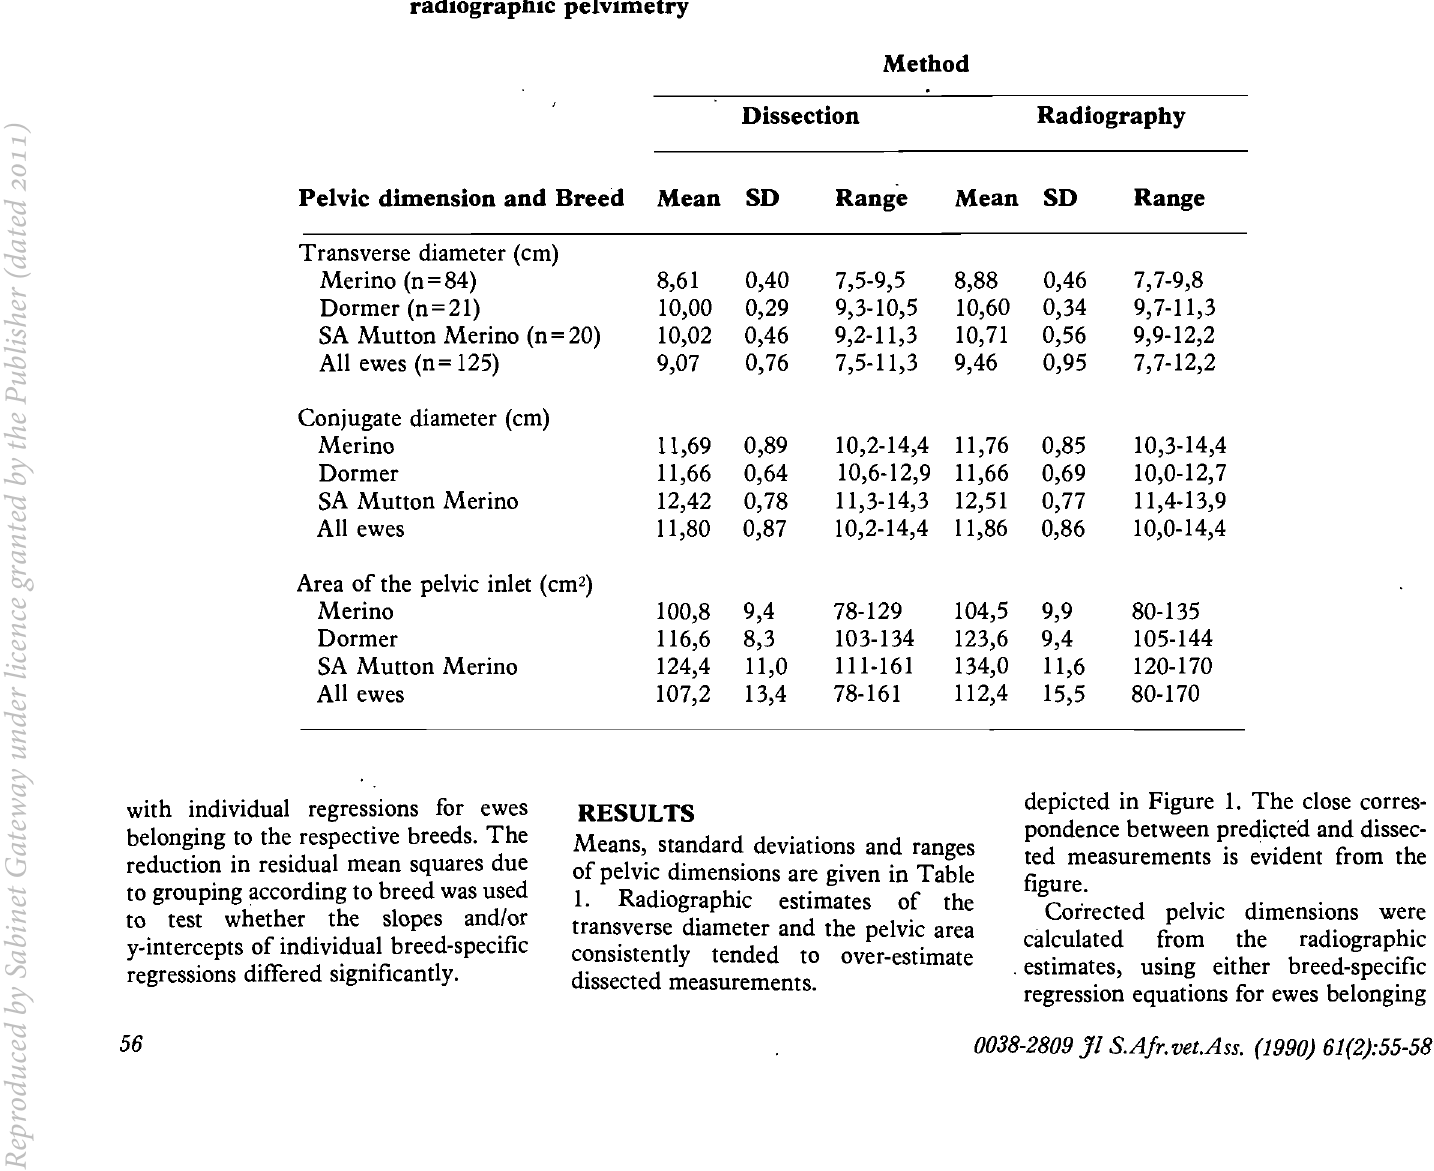
Table 1: Mean, standard deviation (SD) and range of pelvic dimensions of Merino, Dormer and SA Mutton Merino ewes, obtained by dissection and by radiographic pelvimetry